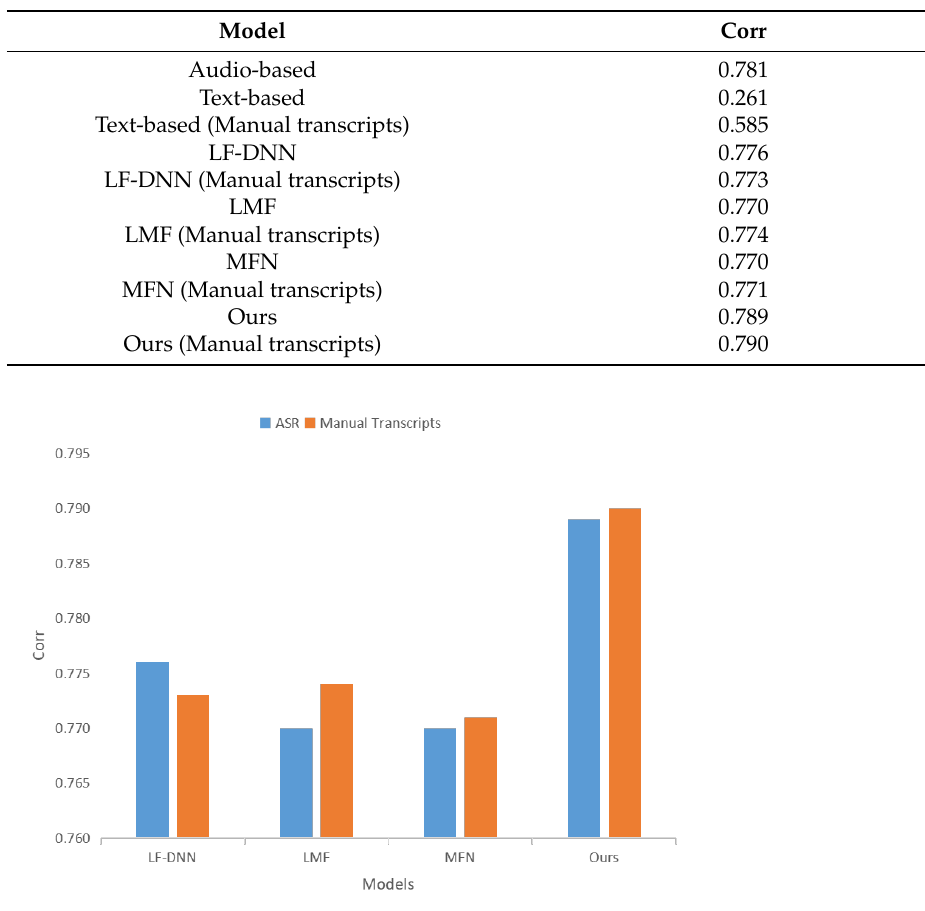
Figure 8. Effect of different text features in Speechocean762 on experimental